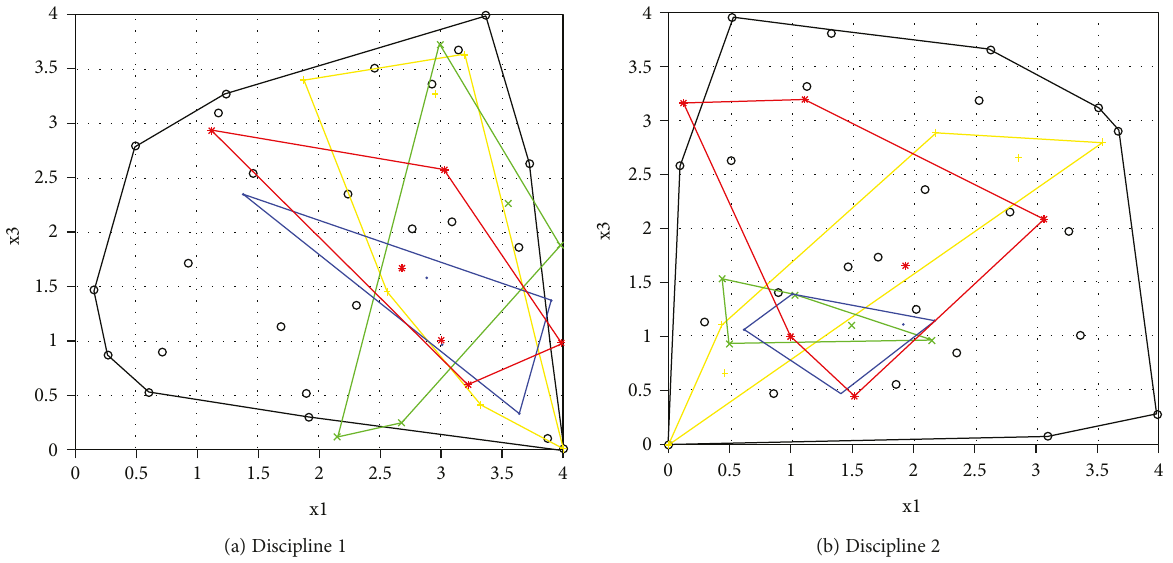
Figure 8: Iteration history on the distribution of discrete design points of DMPS-MDOF. Table 2: Iteration history on variables of discipline 1 and discipline